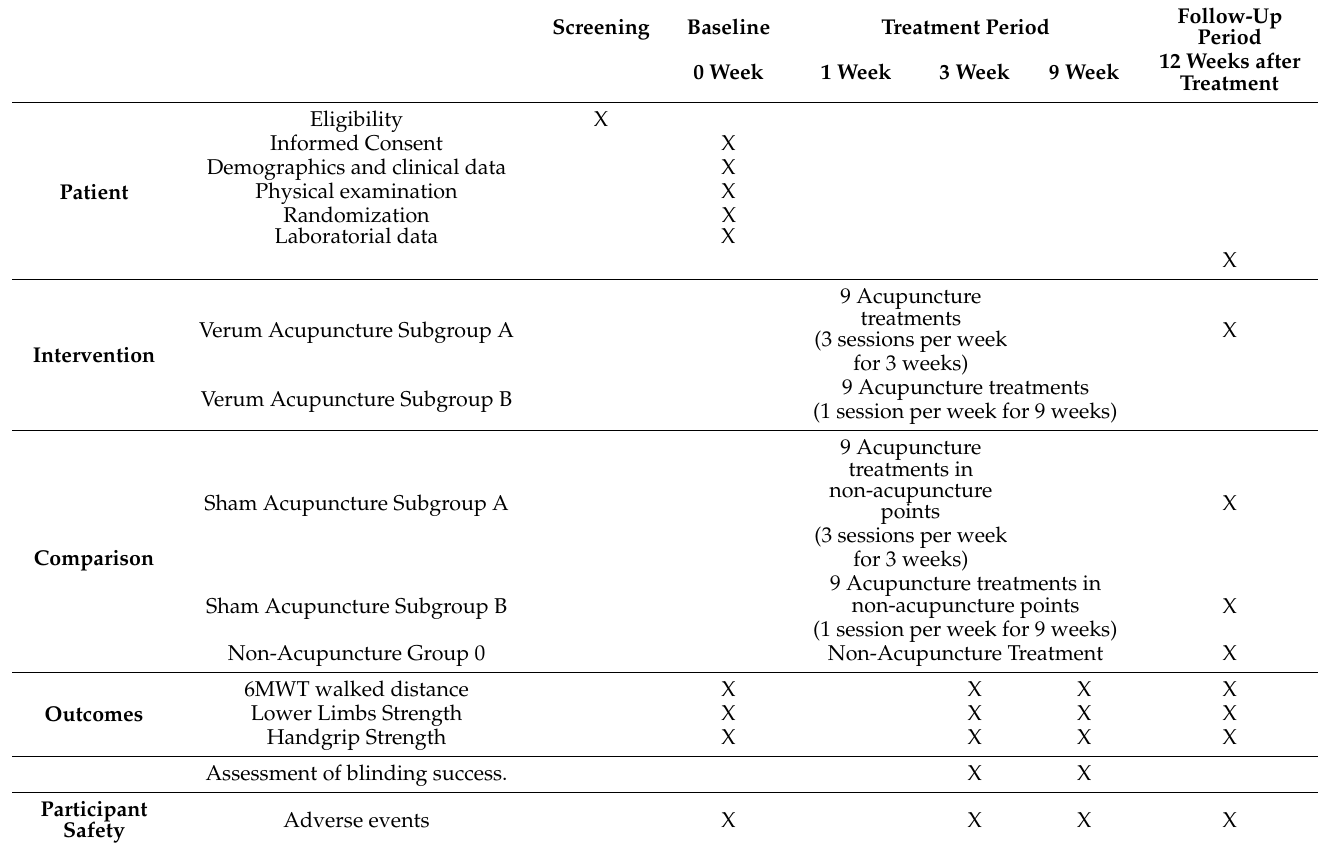
Table A3. Timing of visits and data